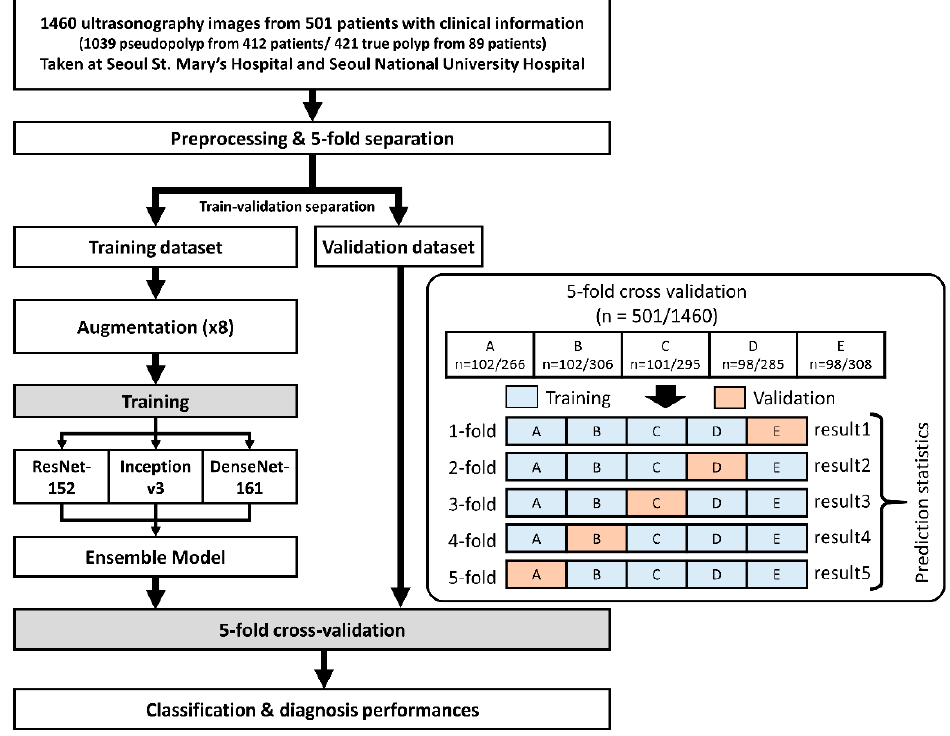
Figure 2. Flow chart of the study procedure. The data collected from our institutions were used for training and validation. A total of 1460 images from 501 patients were randomly separated into five sub-datasets (i.e., A: 102/266, B: 102/306, C: 101/295, D: 98/285, and E: 98/308), and each sub-dataset was used sequentially for training and validation. The sub-dataset results were aggregated to obtain prediction statistics of the model, and patient-specific diagnoses were conducted based on the sub-dataset results where the patients